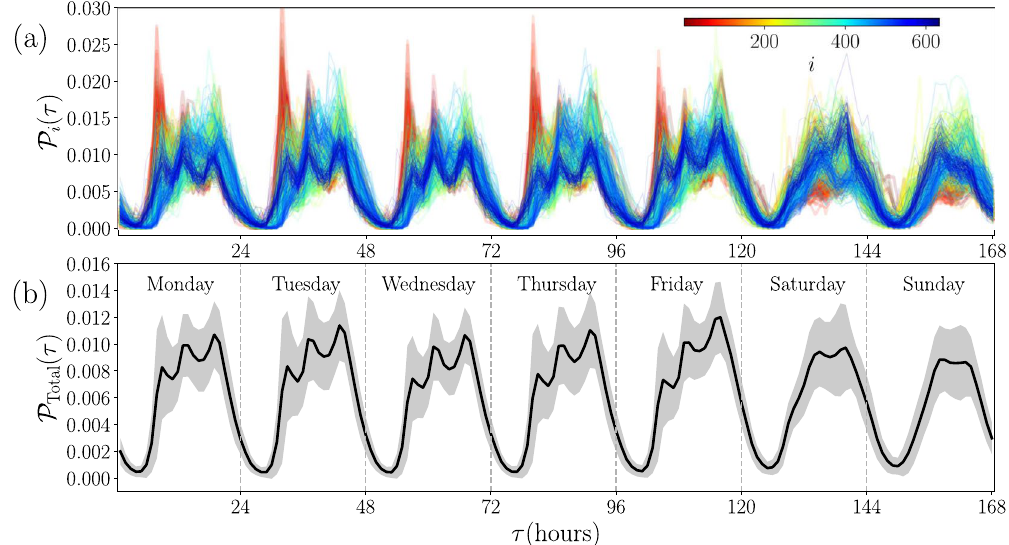
Figure 3. Temporal analysis of check-ins in 632 cities. ( a ) Probability P i (τ) of check-in at times τ in N = 632 cities denoted by i = 1, 2, . . . , N . All the check-ins in each city were gathered by the local time when each register was made. Frequency counts are normalized over the week to obtain each P i (τ) . The time τ can take the values from 1 (the first hour of Monday) to 168 (the last hour of Sunday), and the results for each city i (codified in the colorbar) are presented with continuous lines. ( b ) The probability P Total (τ) obtained for all the check-ins in the 632 cities is plotted with a continuous line. In this case, the standard deviation σ(τ) for all the check- ins and all the cities in ( a ) evaluated at time τ defines variations of this probability. The results are shown as a region defined by P Total (τ) ± σ(τ) presented with gray color. All figures were created using python 3.8 and the matplotlib (3.5.0) package (https:// matpl otlib.